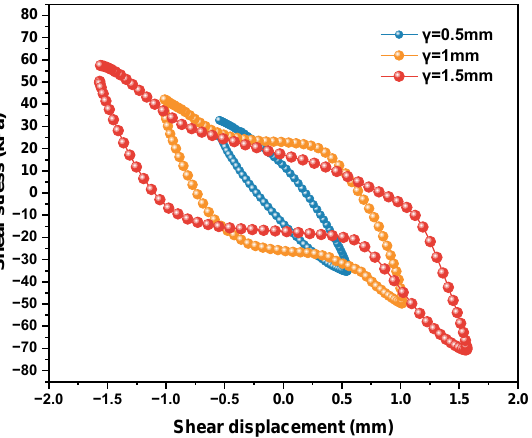
Figure 17. The curves of shear stress and shear displacement under different shear displacement amplitudes.